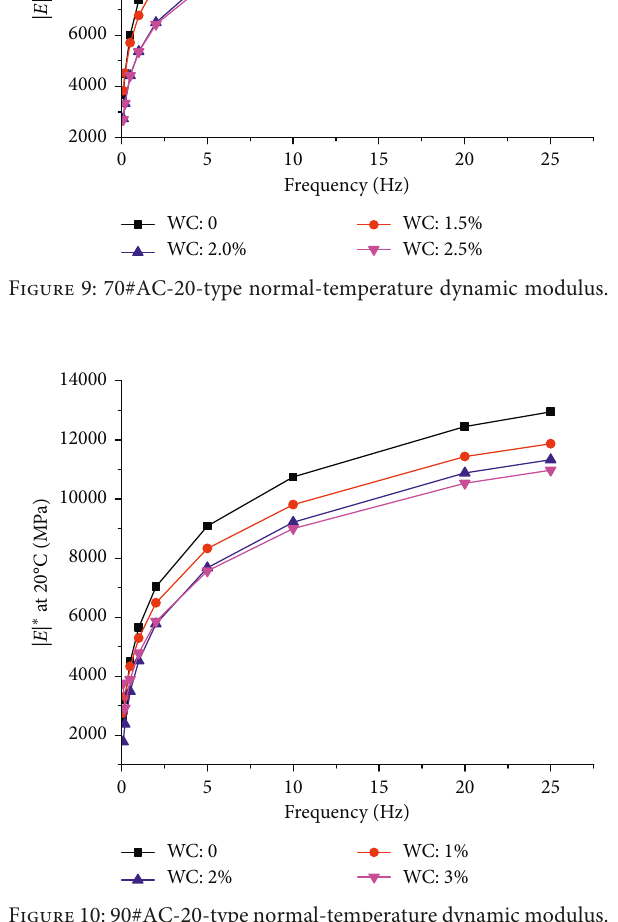
Figure 8: SBS#AC-13-type low-temperature dynamic modulus.